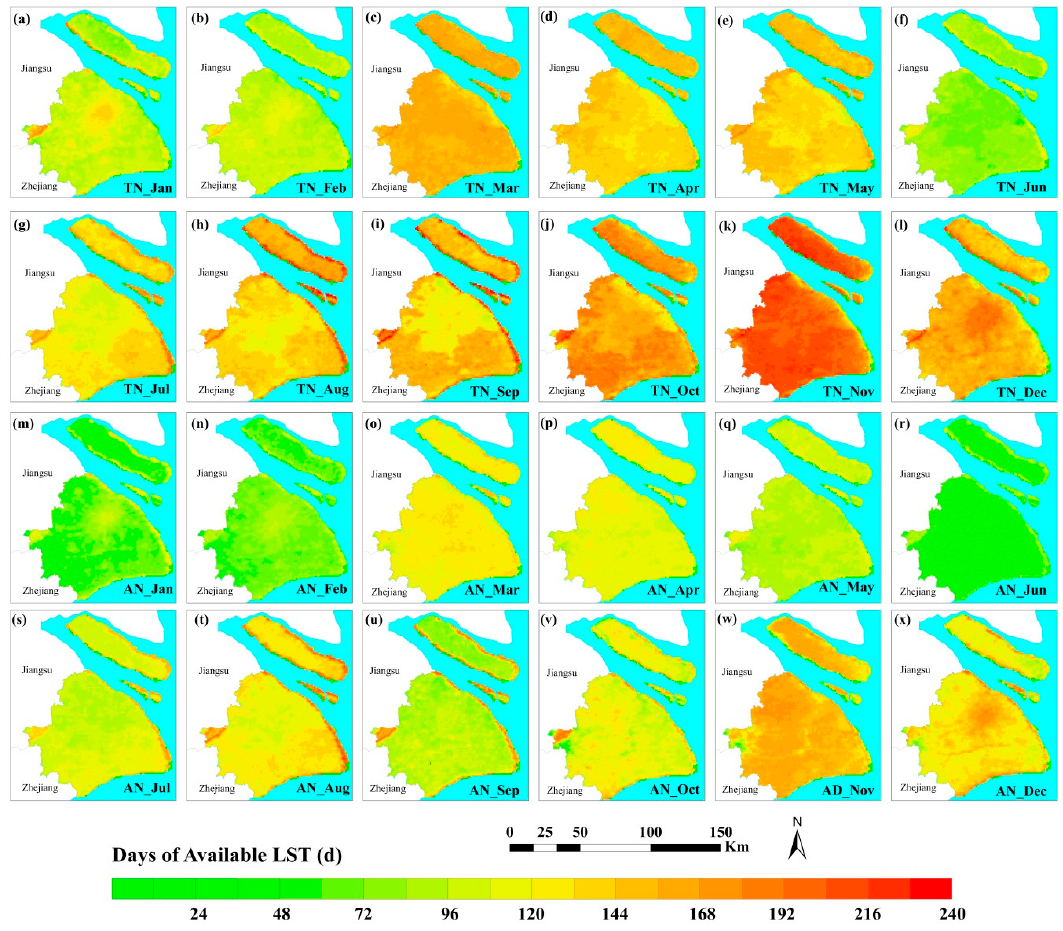
Figure 3. The amount of available nighttime LST per month for MODIS Terra 2000–2013 and Aqua 2002–2013, respectively: ( a – l ) each month at the Terra nighttime (TN) overpass; and ( m – x ) each month at the Aqua nighttime (AN) overpass.